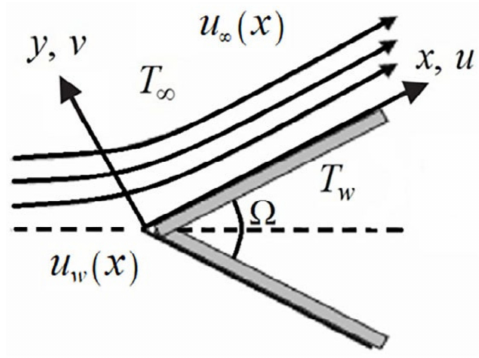
Figure 6. Structure of the